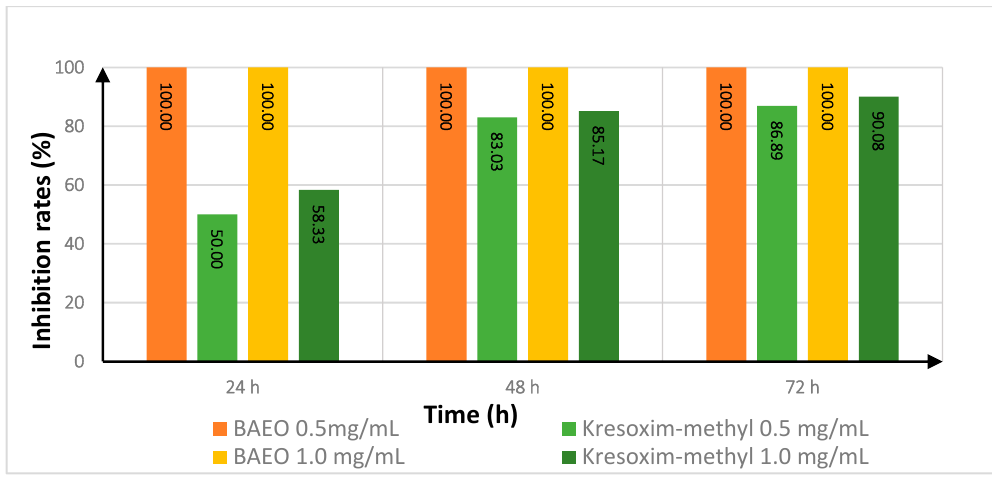
Figure 3. Effect of treatment time on the antifungal activity of BAEO against Alternaria solani .